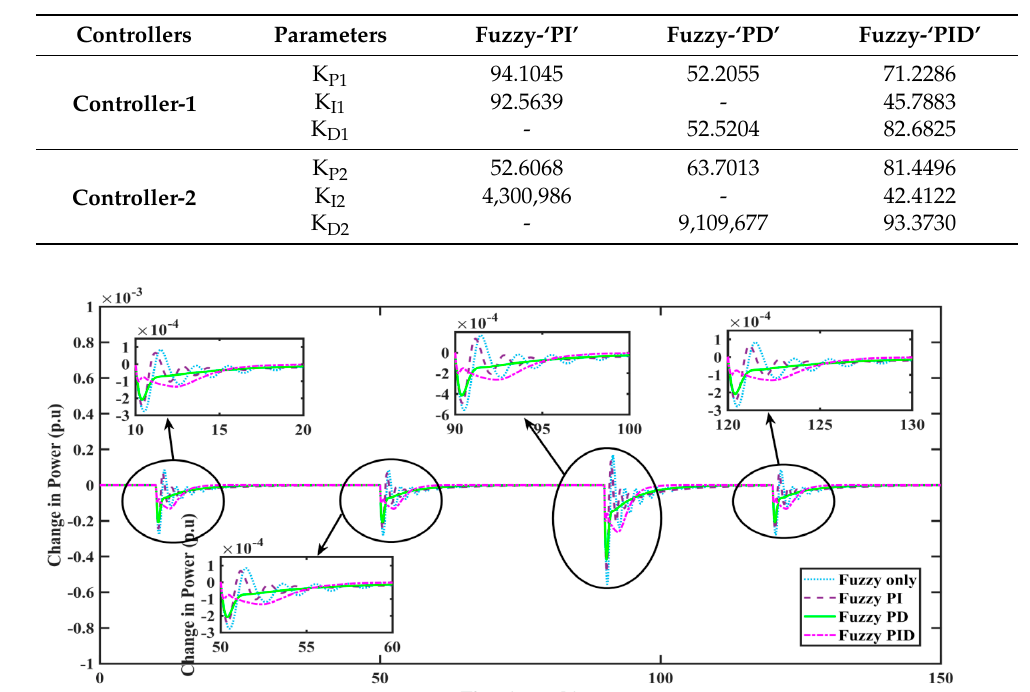
Table 6. Optimal parameters for both control 1 and 2 using ABC algorithm for Case 1 (1% step change in load).